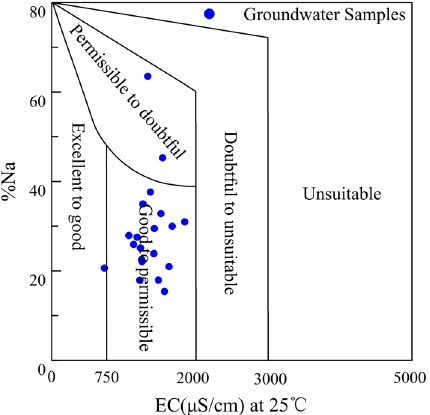
Fig. 7 Wilcox diagram for irrigation water quality